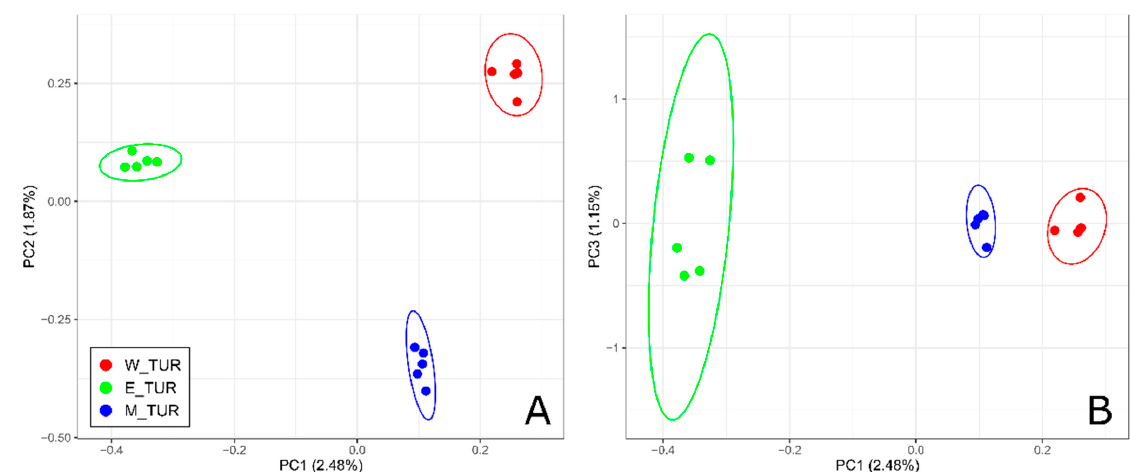
Figure 5. Principal component analysis (PCA) of the groups of Caucasian tur ( Capra caucasica ): ( A ) the first two components (PC1 and PC2), ( B ) the first and third components (PC1 and PC3). W_TUR = West-Caucasian tur, E_TUR = East-Caucasian tur, M_TUR = Mid-Caucasian tur.